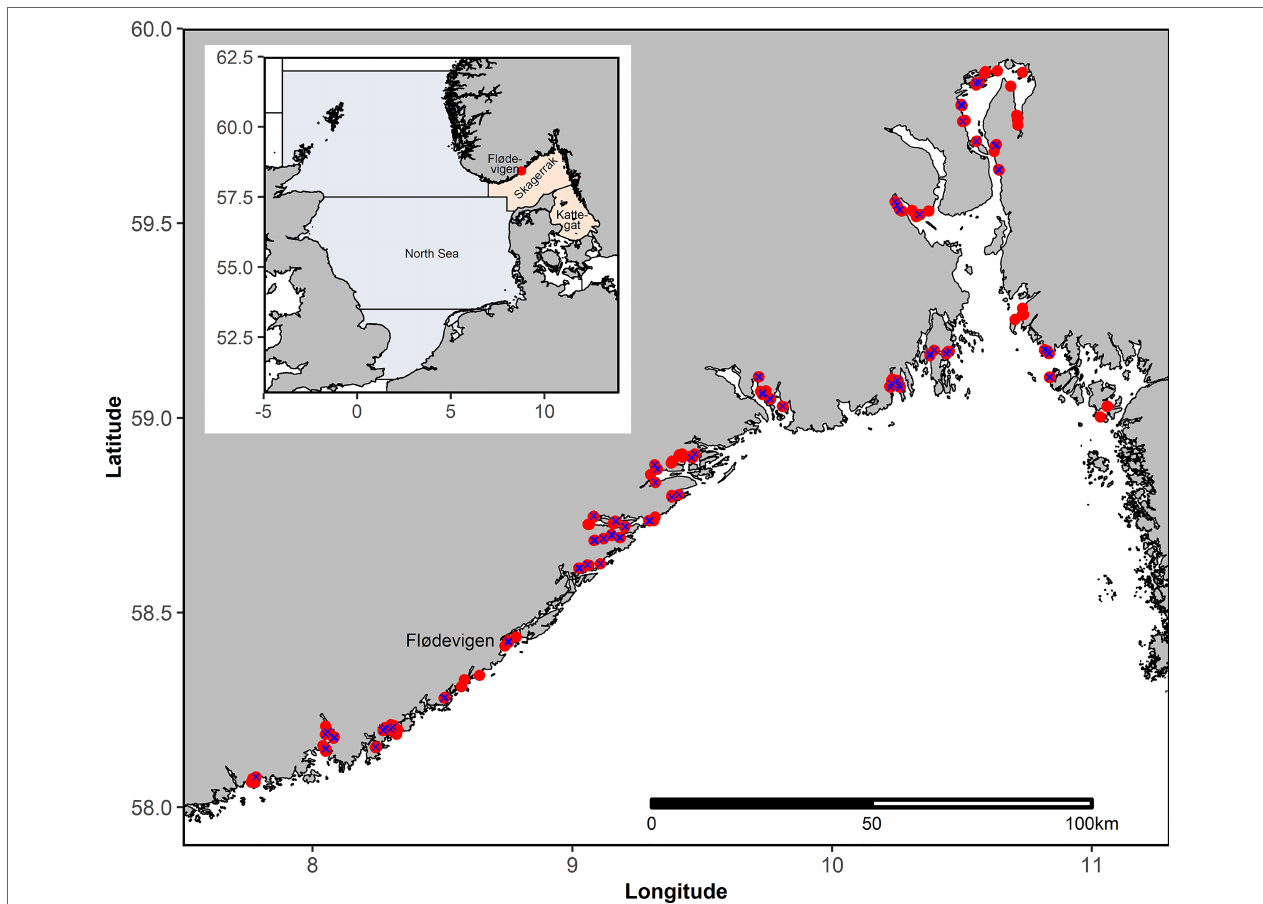
FIGURE 1 | Upper left corner: Overview map showing the North Sea (light blue) and Skagerrak-Kattegat (light red) including the study area. Detailed map including all stations sampled during the annual beach seine survey in September-October between 1919 and 2018. Not all stations are sampled annually. Blue X indicate stations that were sampled more than 95% of the years after